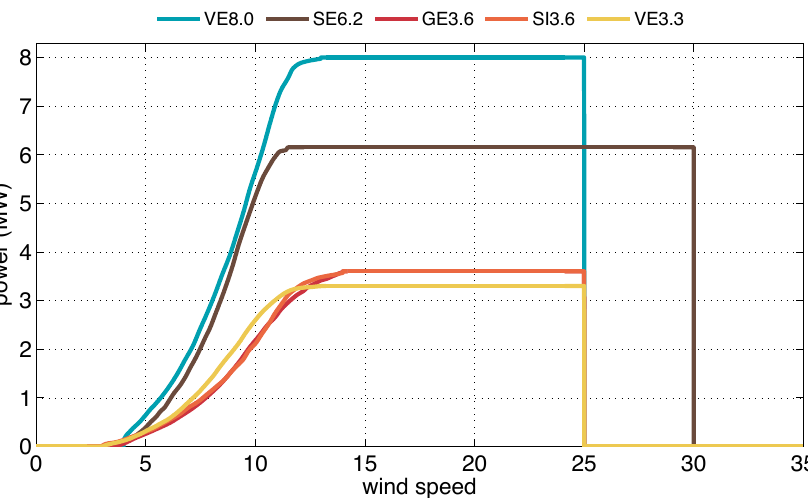
Figure 2. Empirically derived power curves for Vestas V112-3.3 MW (hereafter VE 3.3), General Electric 3.6 s Offshore (GE 3.6), Siemens SWT-3.6-120 (SI 3.6), Senvion 6.2 M 152 (SE 6.2) and the Vestas V164-8.0 MW (VE